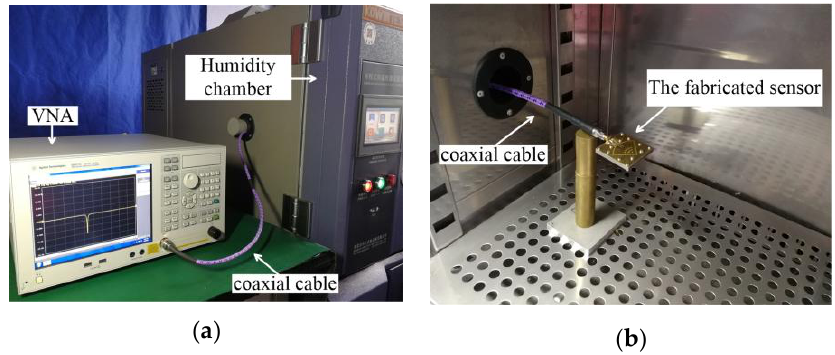
Figure 5. Photographs of the measurement setup for the designed DFSIW re-entrant cavity humidity sensor: ( a ) full measurement setup; ( b ) setup inside the humidity chamber.